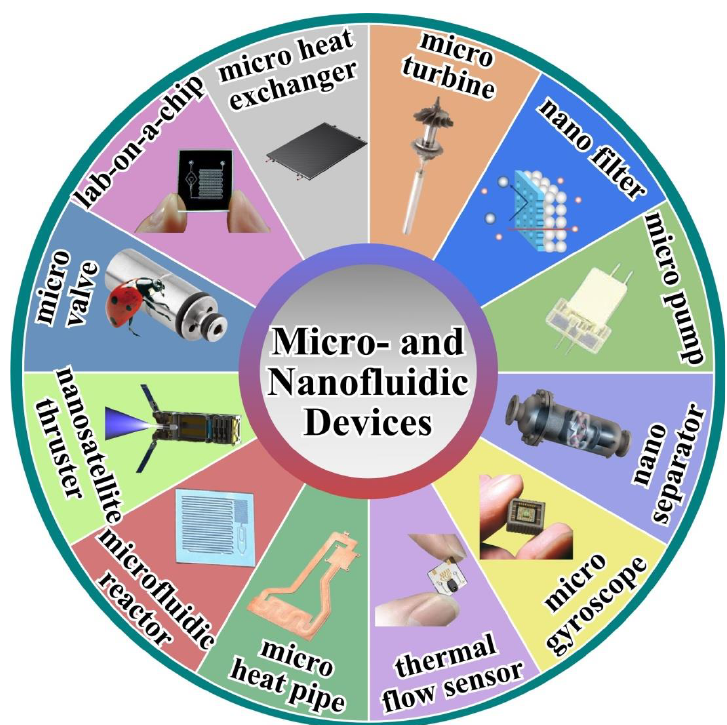
Figure 1. Micro- and nanofluidic devices.